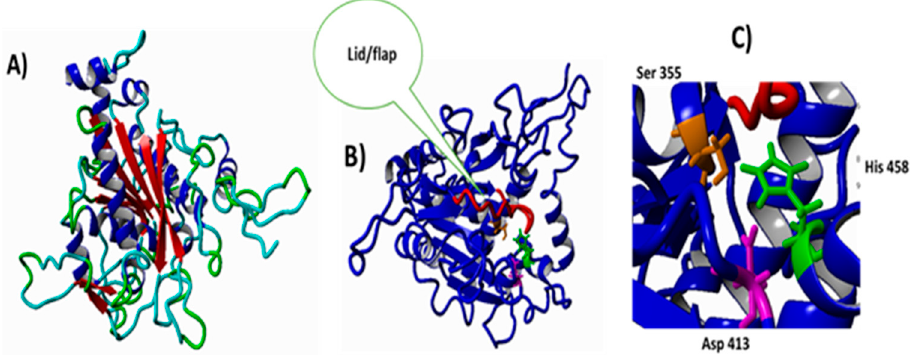
Figure 2. The predicted structure of LIP2 lipase using homology modelling. ( A ) Overview of LIP2-predicted tertiary structure. ( B ) LIP2 with lid and flip labeled in red. ( C ) Position of catalytic triad in the active site of the LIP2 region.